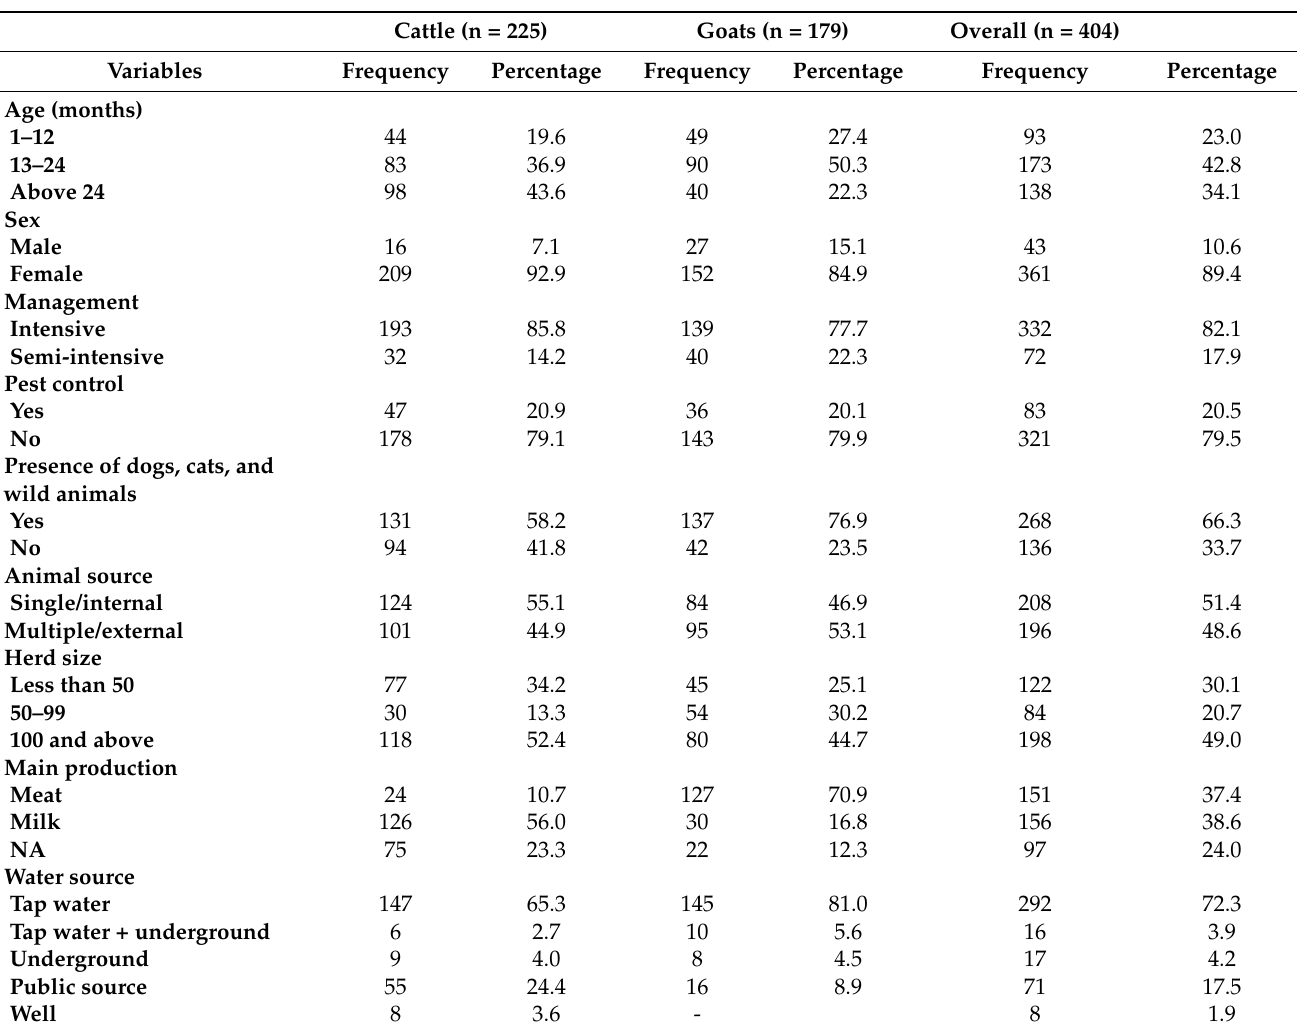
Farm and animal characteristics of the sampled animals from ruminant farms in Selangor,